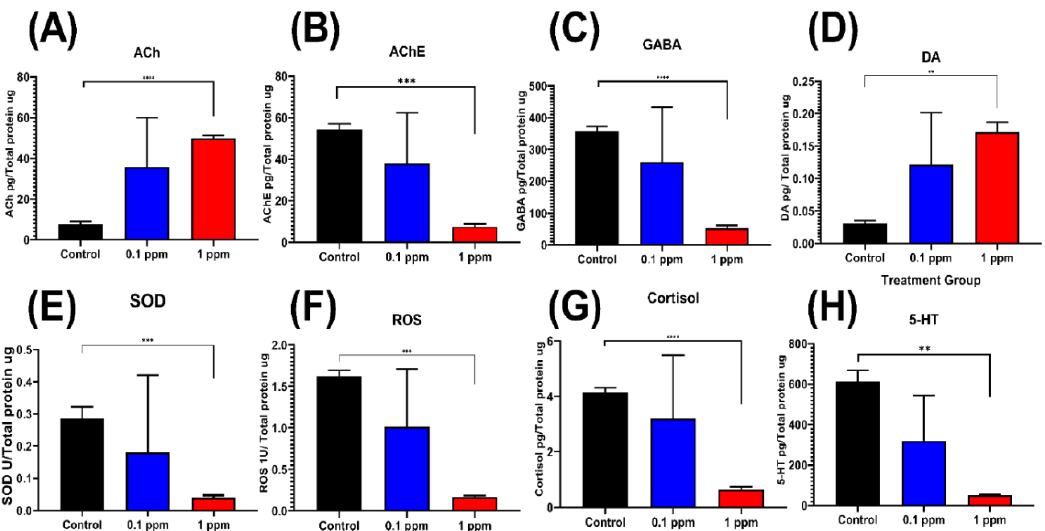
Figure 10. Biochemical Assay for neurotransmitters and enzymes content in zebrafish brains after exposed to different doses (0.1 and 1 ppm) of Paclobutrazol. Eight biomarkers were tested including ( A ) acetylcholine (ACh), ( B ) acetylcholine esterase (AChE), ( C ) γ-Aminobutyric acid (GABA), ( D ) dopamine, ( E ) superoxide dismutase (SOD_, and ( F ) reactive oxygen species (ROS), ( G ) cortisol and ( H ) serotonin (5-HT). All data are expressed as means ± S.E.M and significance were measured and analyzed by one-way ANOVA (** p < 0.01, *** p < 0.001, **** p < 0.0001).